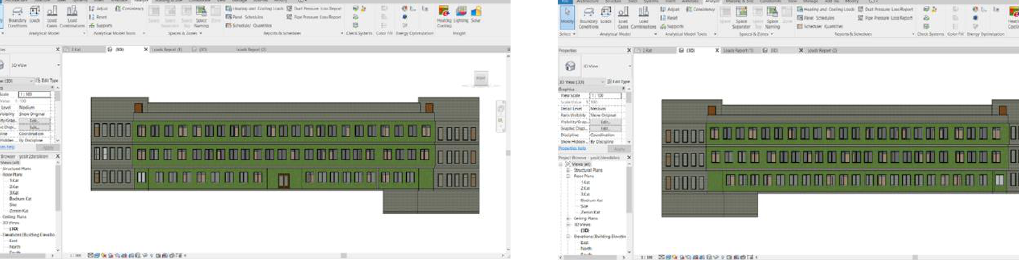
Figure 18 R2 Classrooms building west facade view with vertical green system applied